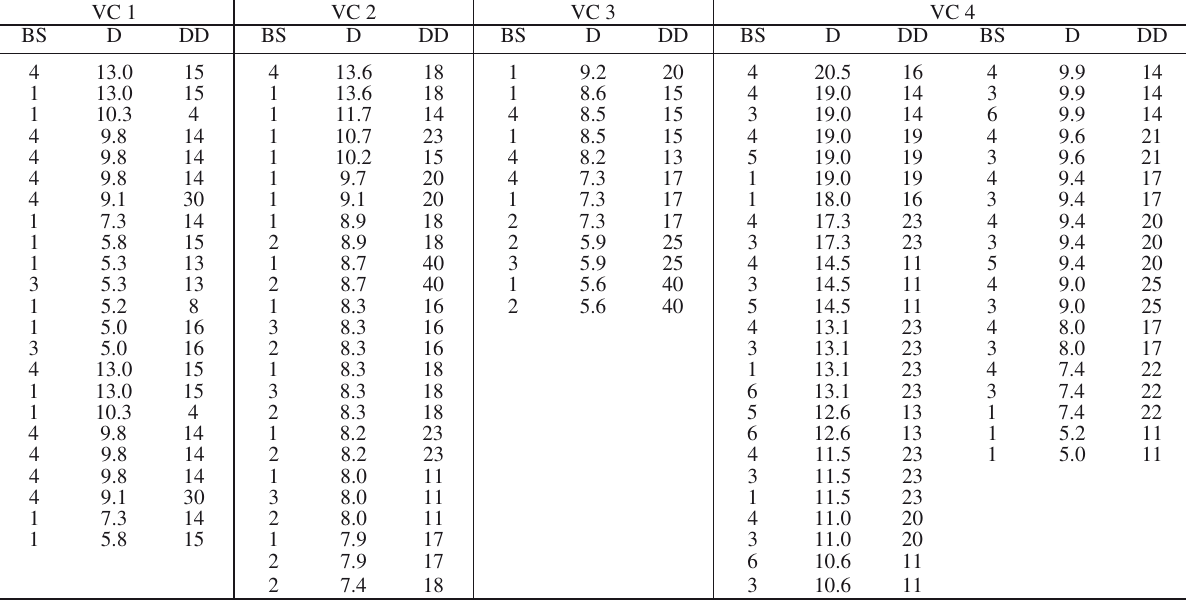
Table 4. – Data to bivalve species found in O. vulgaris middens in Rods inlet per visual census 1-4 (VCs 1-4). BS, bivalve species (1, Ensis arcuatus ; 2, Glycimeris glycimeris ; 3, Lutraria lutraria ; 4, Pecten maximus ; 5, Venerupis spp.; 6, Mytillus galloprovincialis ); VC,